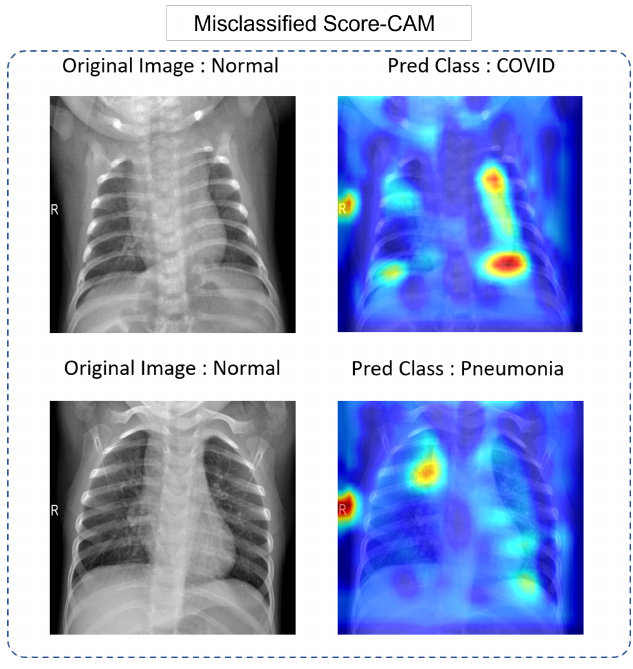
Figure 10. Examples of misclassified samples with